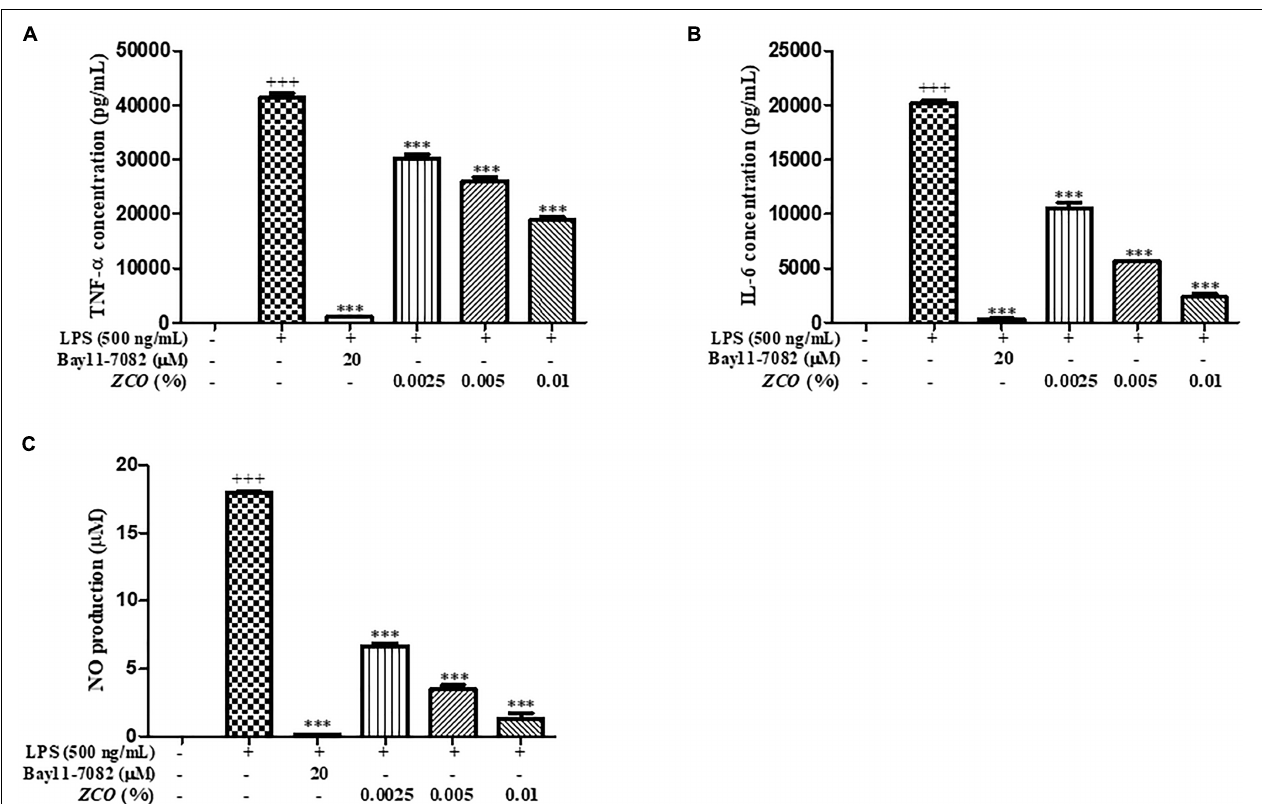
FIGURE 4 | Effect of ZCO on the production of inflammatory mediators in LPS-activated RAW264.7 cells. RAW264.7 cells seeded into 48-well plate were pretreated with ZCO (0.0025, 0.005, and 0.01%) or Bay11-7082 (20 µ M) for 2 h prior to addition of LPS (500 ng/mL) for 24 h. TNF- α (A) and IL-6 (B) in the supernatants was measured by ELISA and NO production (C) in the supernatants was detected by Griess reagent. Experiments were conducted in quadruplicate and expressed as mean ± SEM ( ∗∗∗ P < 0.001 versus with LPS group). +++ means the significance compared with the mock cells (deal with